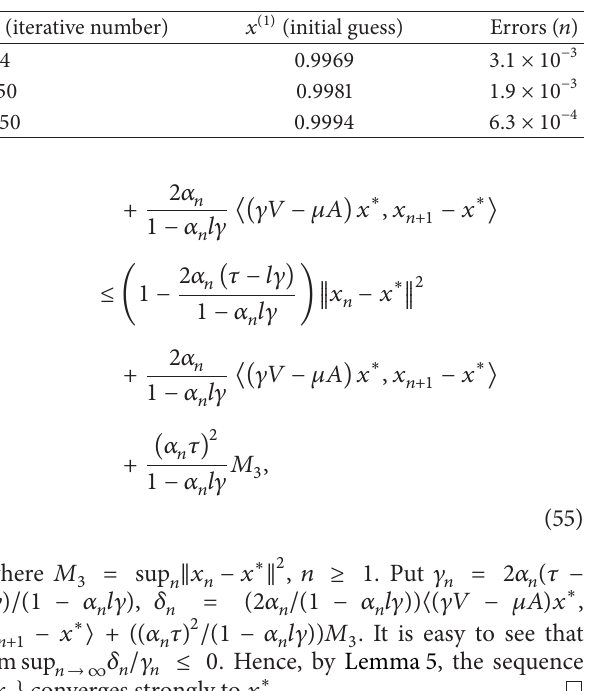
Table 1: 𝑥 1 = 1/2 . Table 2: (a) 𝑥 (1) = (1,0) ⊤ . (b) 𝑥 (1) = (1, 0) ⊤